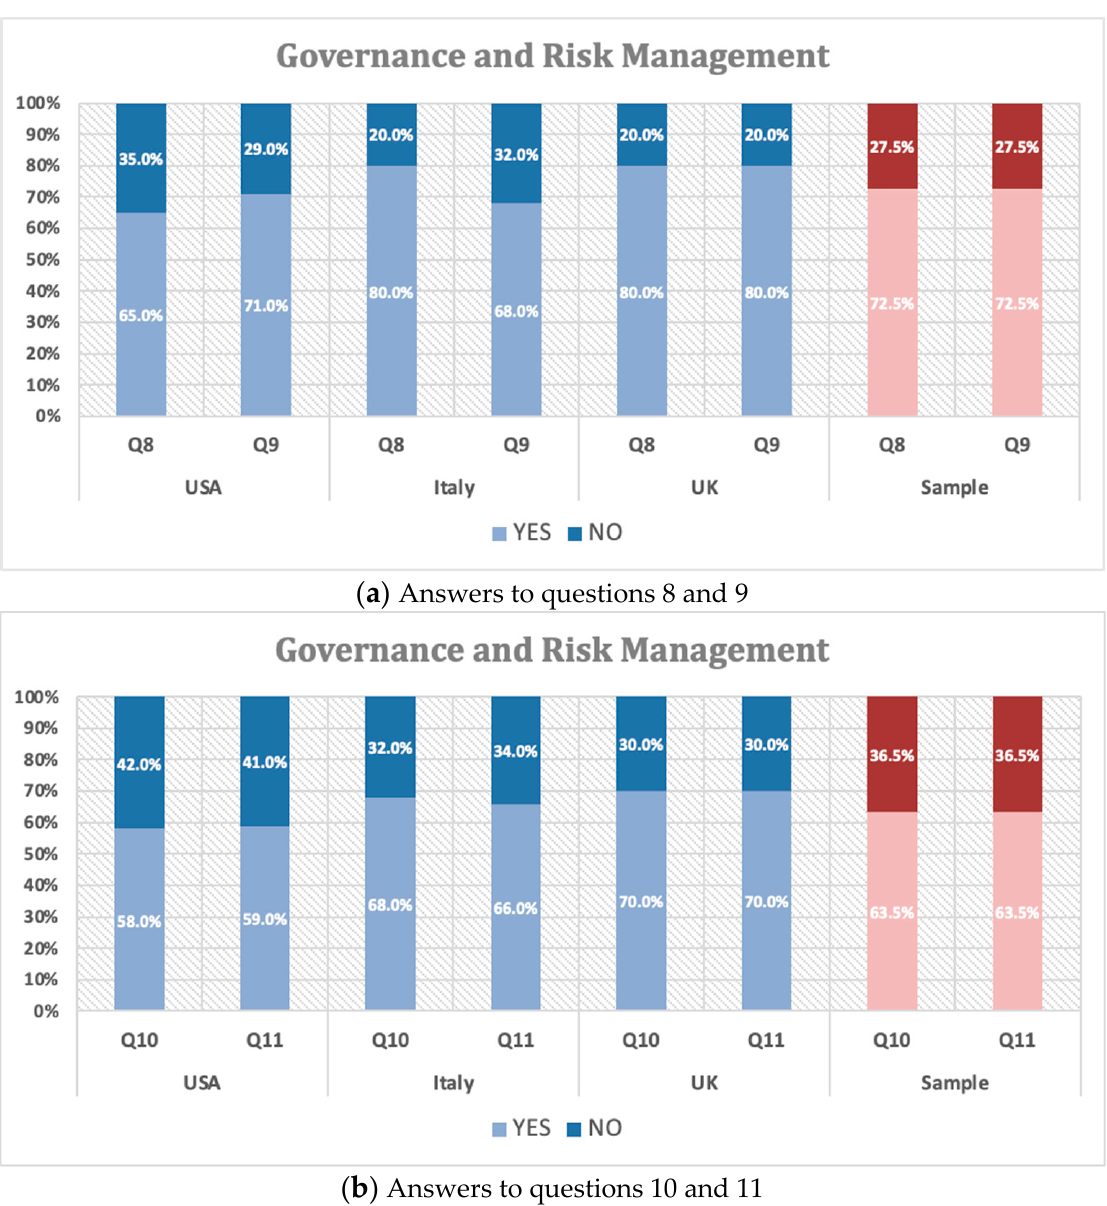
Figure 5. Answers to questions about the governance of risk management by country of respond- ents.